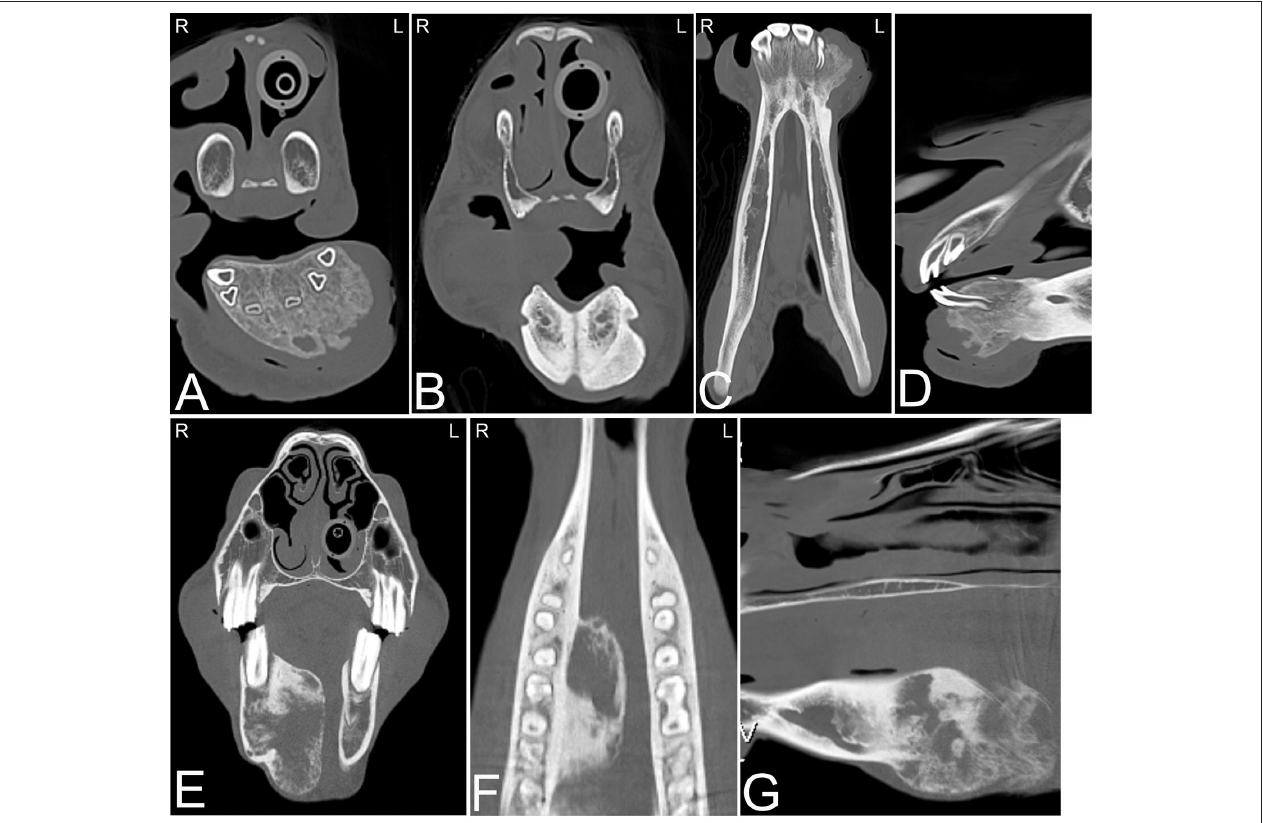
FIGURE 17 | Ossifying fibroma and squamous cell carcinoma. Several head tumors can have a similar CT appearance. (A–D) Computed tomography images of the head of a 6-month-old horse presented for swelling around the rostral aspect of the mandible. Transverse (A,B) , dorsal (C) and sagittal (D) CT images displayed in a bone window reveal an area of indistinct osteolysis and osteoproliferative changes involving the most rostral aspect of both mandibles. No dental abnormalities were noted. The rostral aspect of the mandible was removed surgically and histopathology confirmed an ossifying fibroma. (E–G) Computed tomography images of the head of a 22-year old American Paint horse presented for swelling in the mandibular area. Transverse (E) , dorsal (D) , and sagittal (G) CT images of head displayed in a bone window reveal a large osteolytic and -productive mass in the right mandibular area. Mild asymmetric widening of the periodontal space around the caudal premolar and rostral mandibular molar teeth is noted in this area. Histopathology confirmed a squamous cell carcinoma. L, left; R,